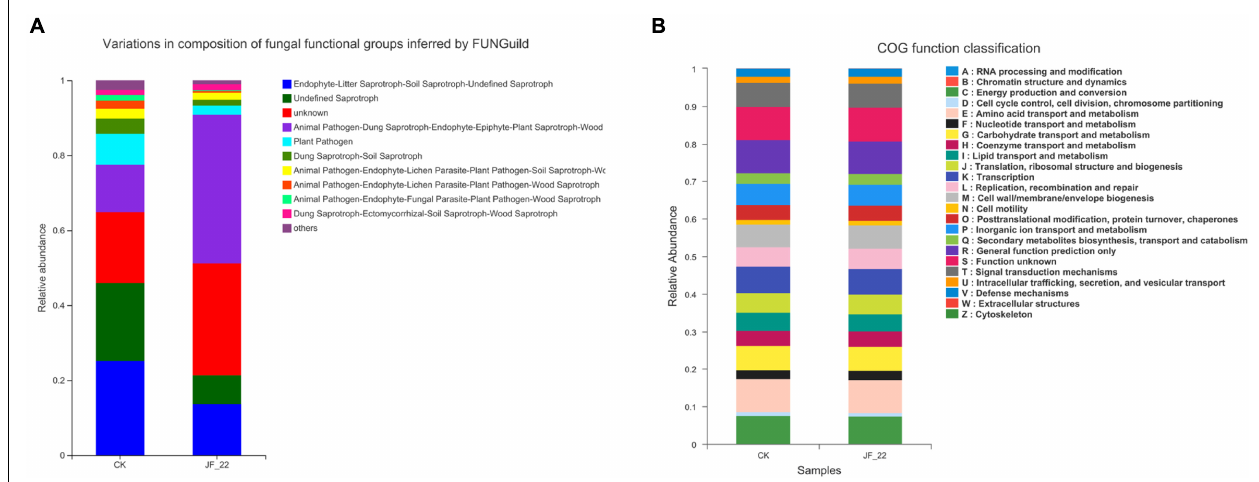
FIGURE 4 | Analysis of the function of the rhizosphere microbial community. (A) COG function classification analysis, and (B) FUNGuide functional classification statistical